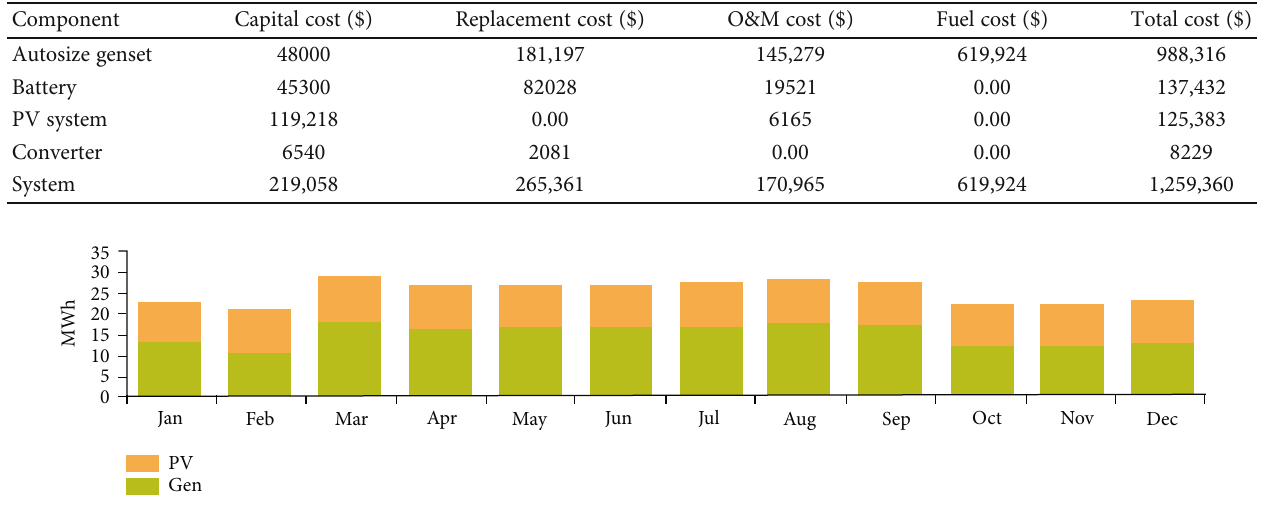
Table 8: Optimized cost summary of the solar-diesel-battery system for the full-option scenario.